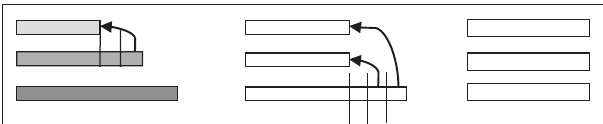
Let x < x < x be measurements. 1 2 3 Even out the difference between and and Next, even out the difference between and the evened